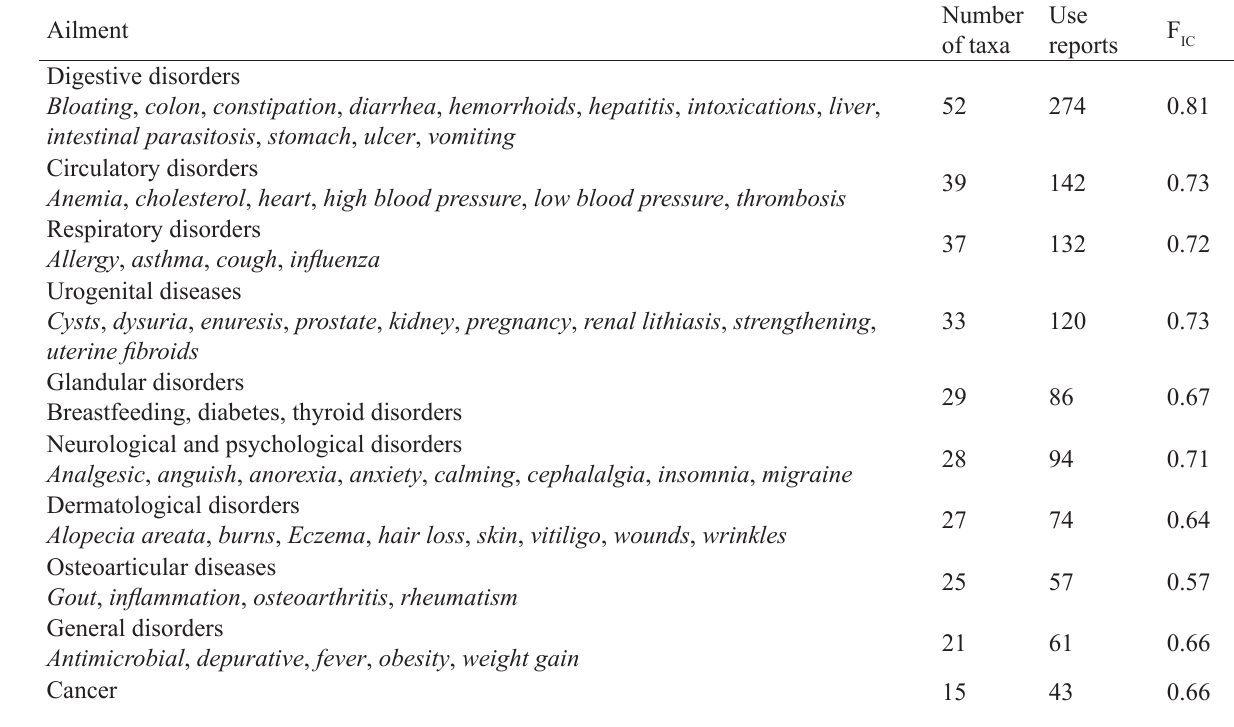
Table 4. Informant consensus factor for commonly used medicinal